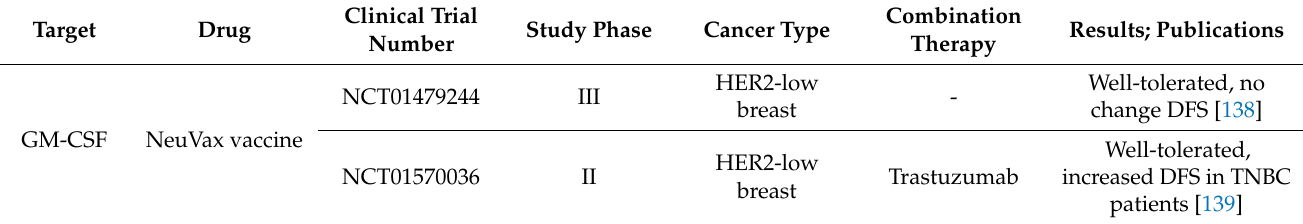
Table 3. Summary of clinical trials targeting Granulocyte-Macrophage Colony-Stimulatory Factor (GM-CSF), Colony Stimu- lating Factor-1 Receptor (CSF1R) and Macrophage Colony-Stimulatory Factor (M-CSF) in breast cancer. NeuVax = HER2 vaccine with GM-CSF; DCIS = ductal carcinoma in situ; DFS = disease free survival; TAMs = tumor associated macrophages; PFS = progression free